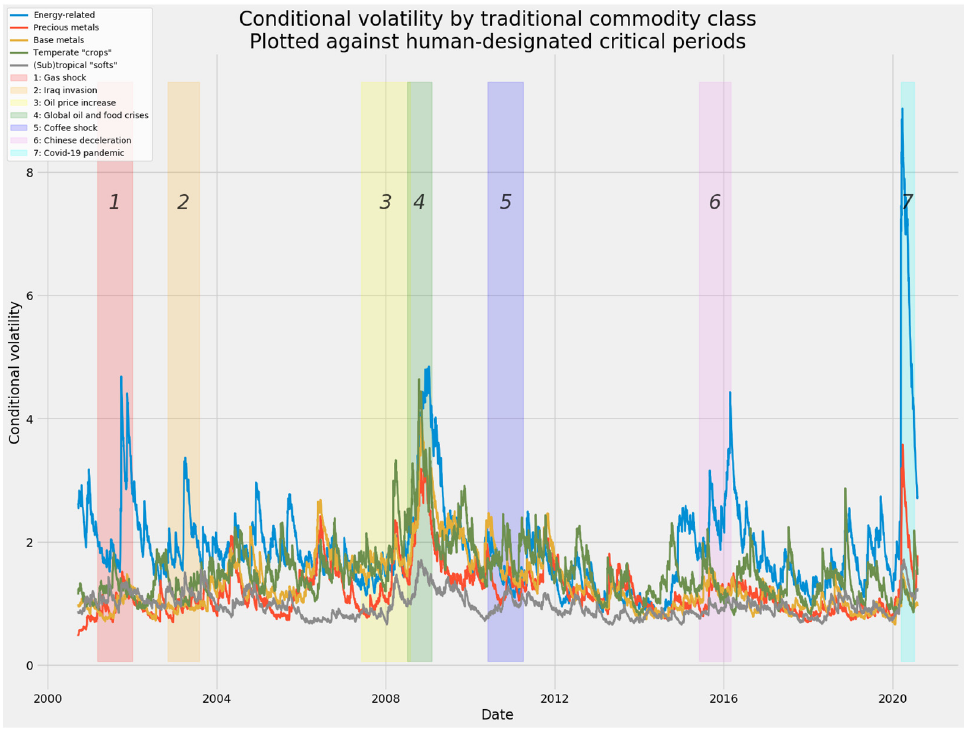
Figure 40. Six human-defined commodity crises, 2000–2020, plus the COVID-19 pandemic.